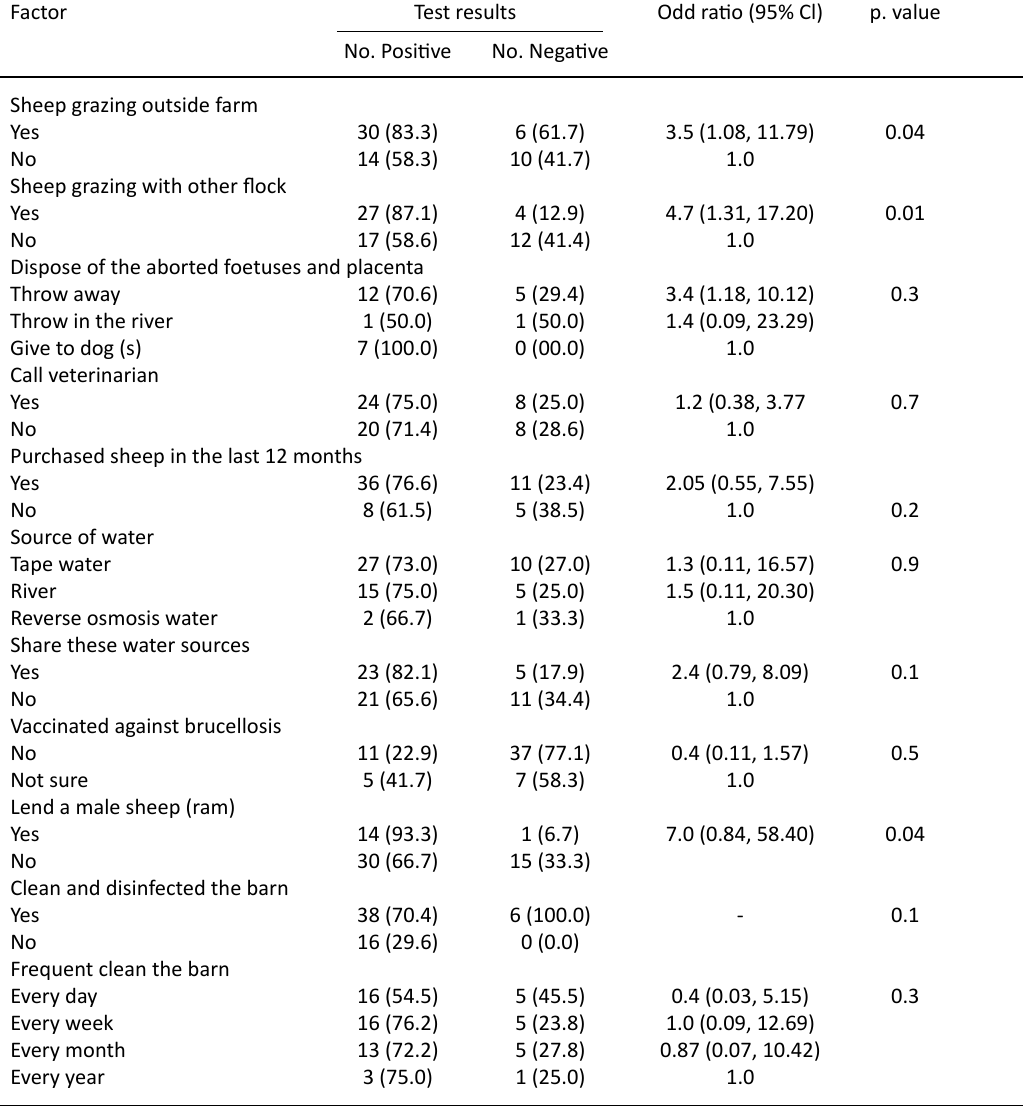
Table 3. Animal level apparent (test) seroprevalence of brucellosis in sheep in four counties County No. tested No. positive Prevalence % 95%Cl p. value Abu-khaseeb 88 15 17 9.8, 26.5 0.01* Al-Dyr 80 25 31 21.1, 42.3 Al-Qurnah 107 32 30 21.5, 39.6 Shatt-Alarab 87 34 39 28.7, 50.1